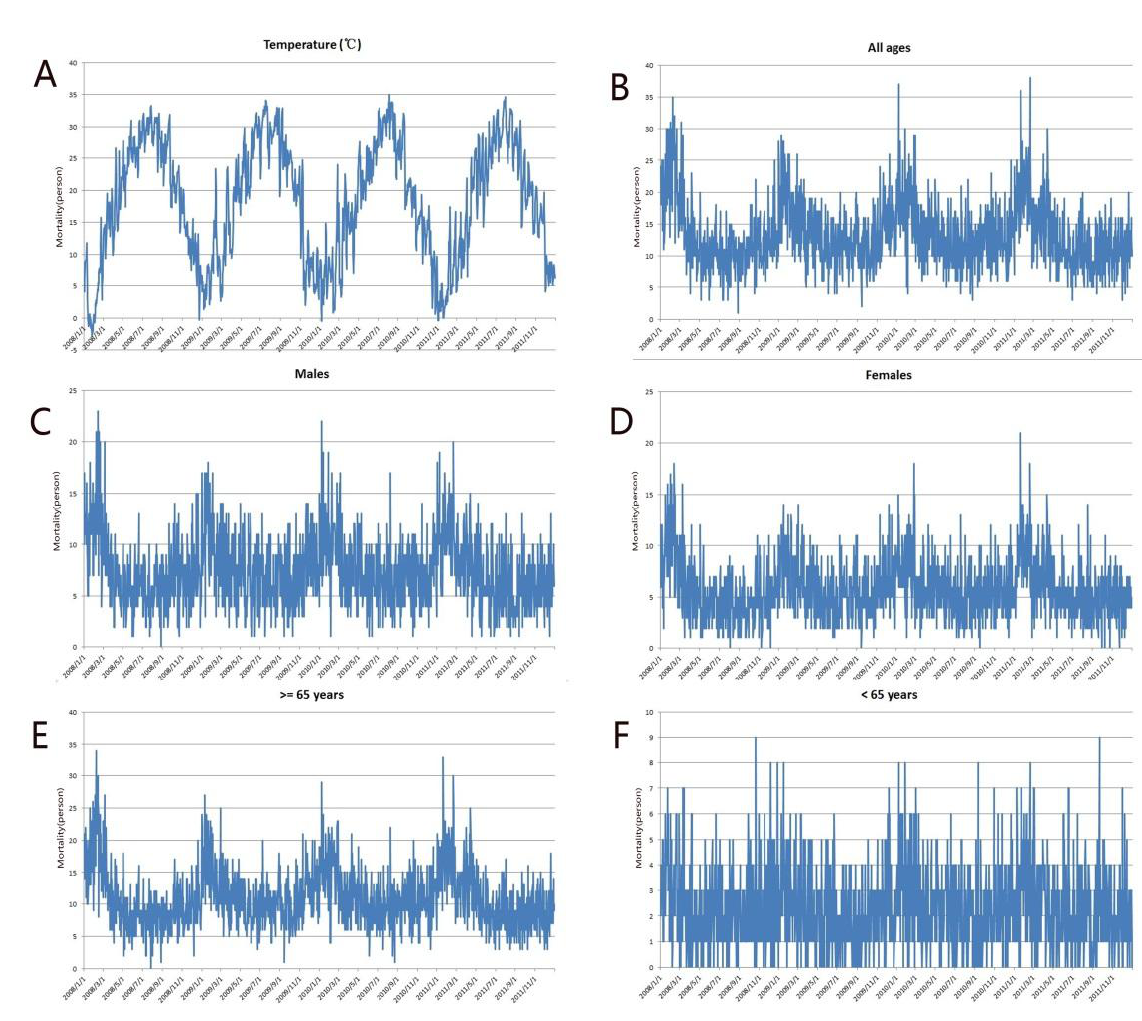
Figure 2. Time series of daily mean temperature ( A ), and time series of CVD mortality for ( B ) all ages, ( C ) males, ( D ) females, ( E ) those ≥65 years, ( F ) those <65 years, all of the vertical axis in these subfigures denote death